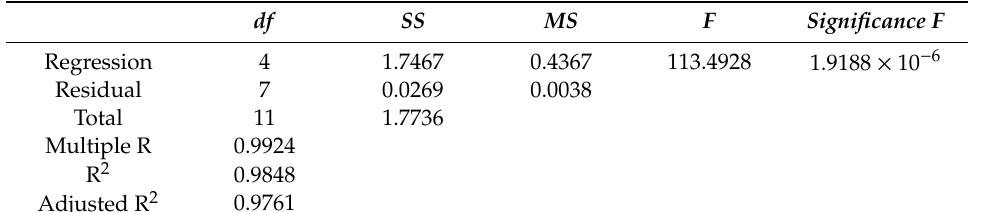
Table 3. Summary of the analysis of variance (ANOVA).